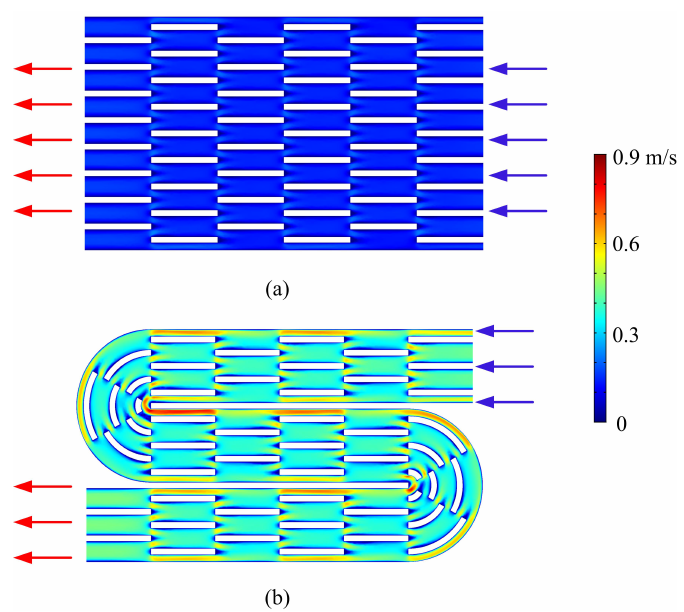
Figure 15. Velocity distribution at volumetric flow rate of 18 cm 3 s − 1 in ( a ) Offset strip fin design ( b ) New offset